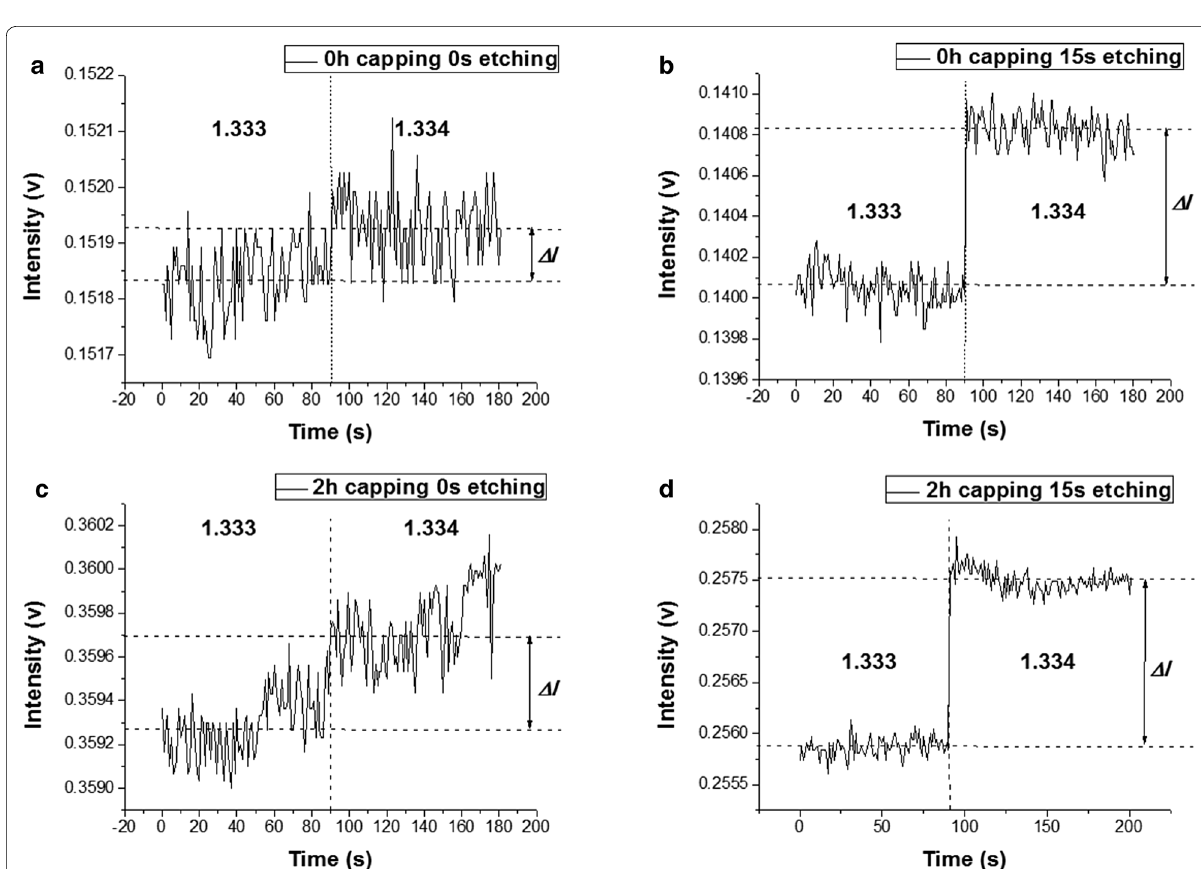
Fig. 7 Measurement of fine change of refractive index using FO‑LSPR sensor with a 0 h Au capping and 0 s etching, b 0 h Au capping and 15 s etching, c 2 h Au capping and 0 s etching, and d 2 h Au capping and 15 s etching, respectively